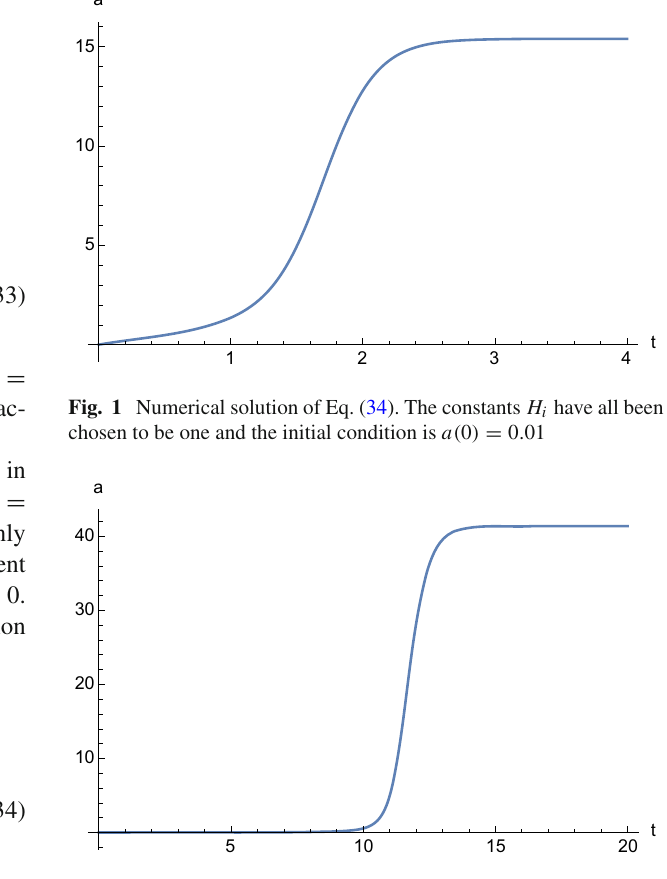
Fig. 2 Numerical solution of Eq. (35). The constants H i have all been chosen to be one and the initial condition is a ( 0 ) = 0 . 01